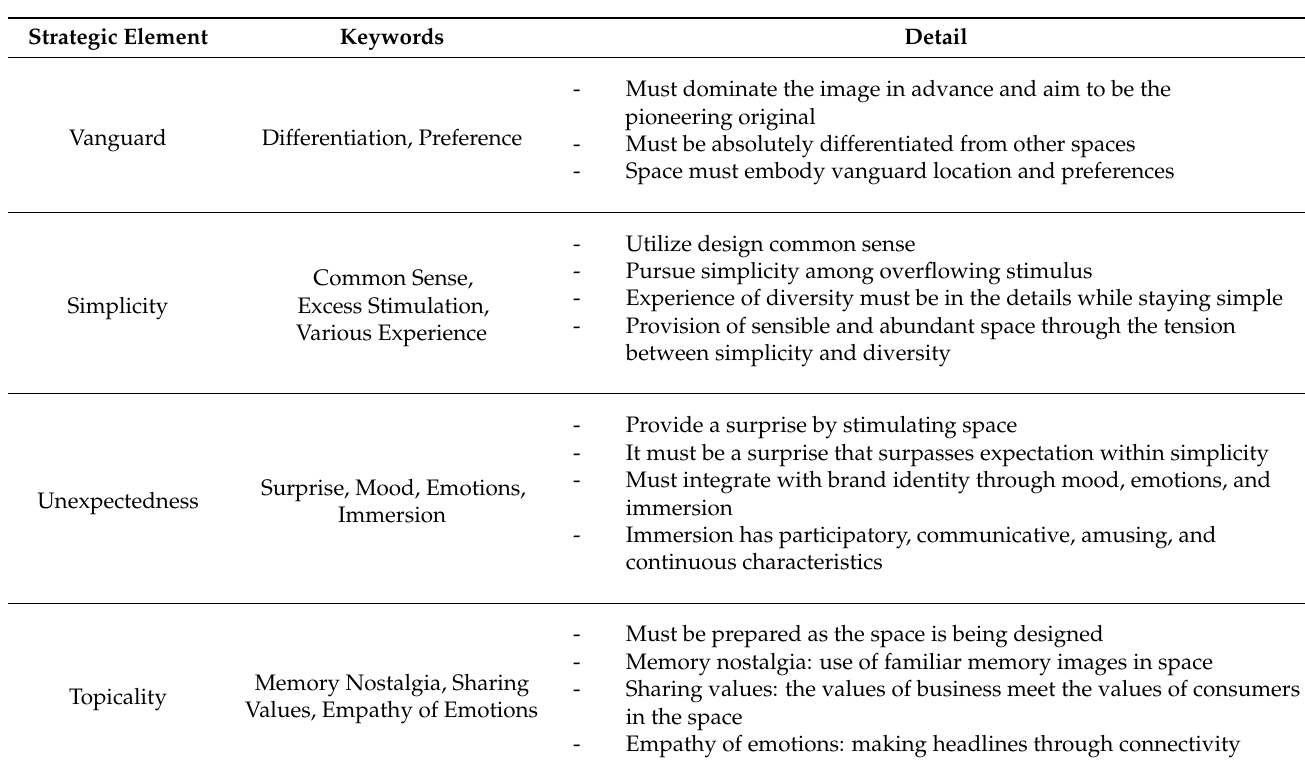
Table 2. Principles of spatial design